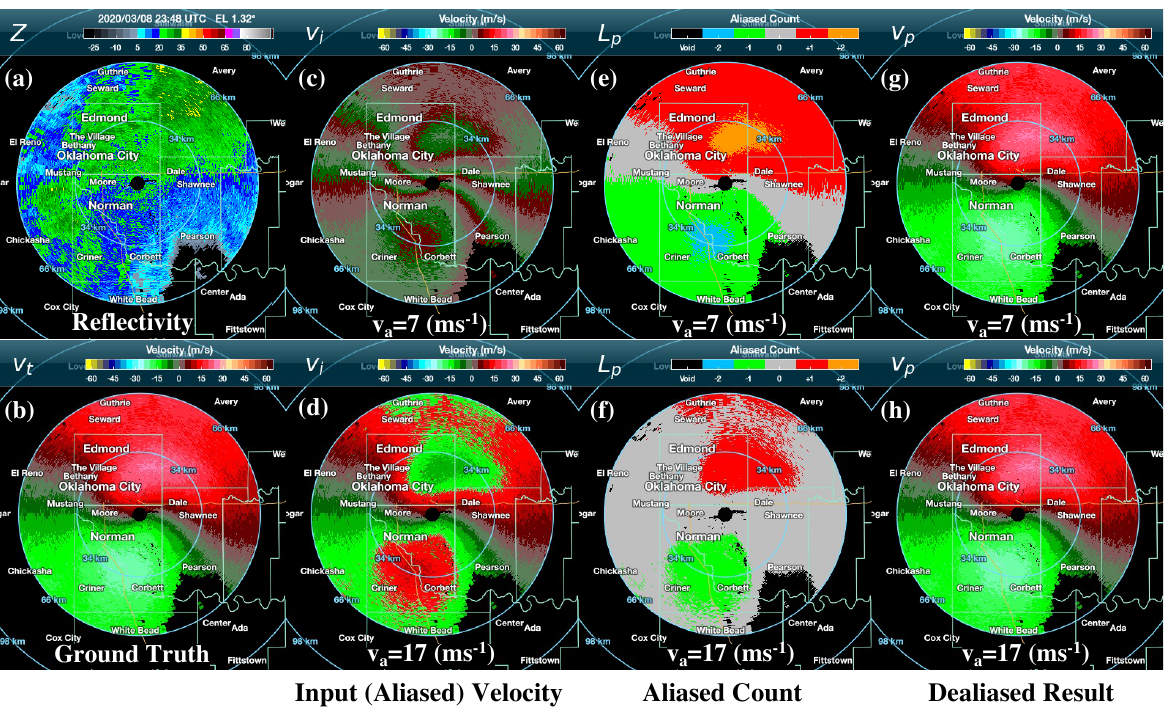
Figure 3. Results of the process of velocity dealiasing using the labels predicted by the CNN. In this example, the data were collected from the KTLX radar on 8 March 2020 23:48 UTC. Figure 3 ( a ) Z is the radar reflectivity. The input velocity v i is obtained by aliasing ( b ) v t (ground truth)